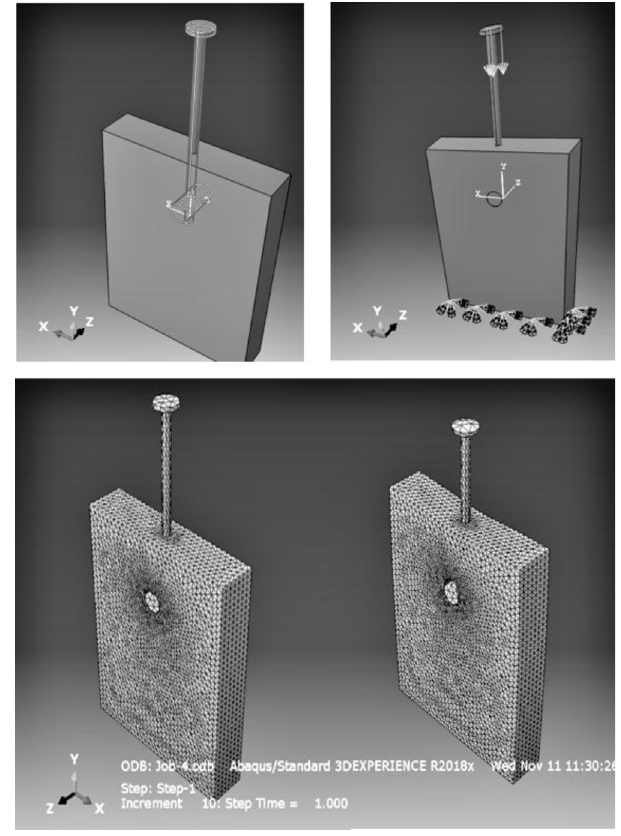
Fig. 17. (Top) Assembly and boundary conditions, (Bottom) mesh and deformed